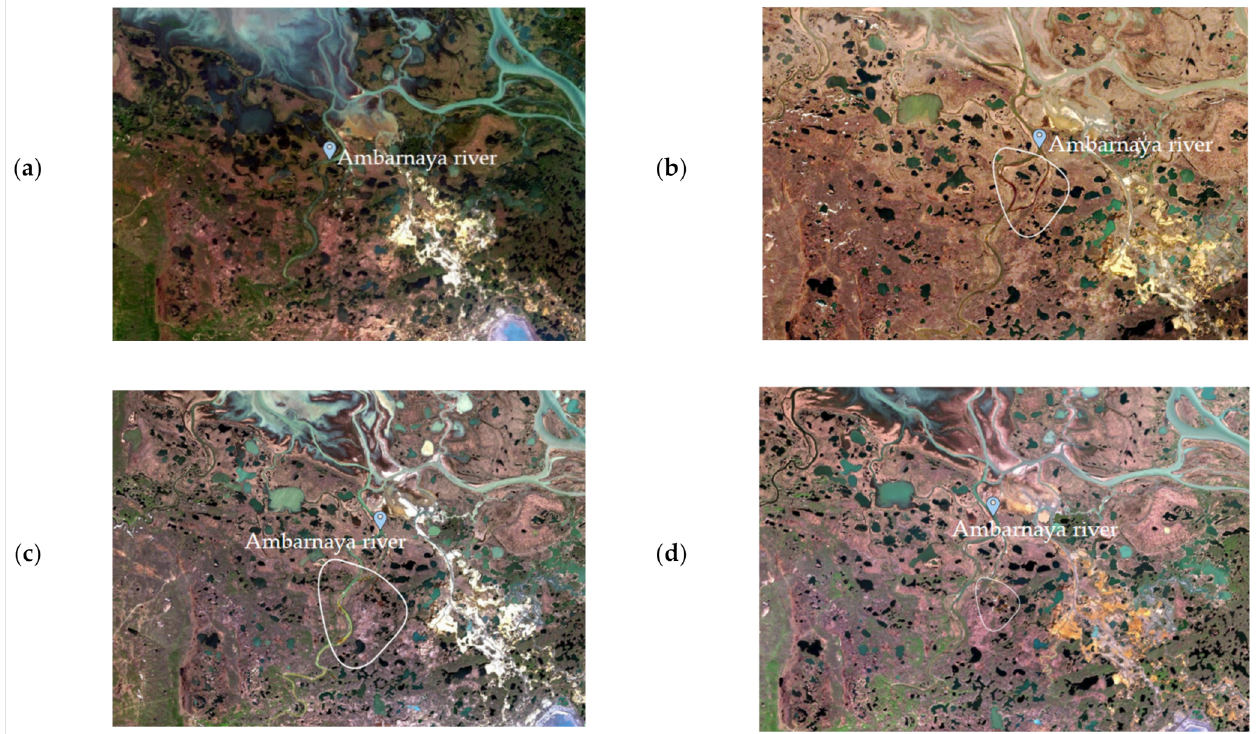
Figure 5. Visual Oil Spill Analysis ( a ) 10 May 2020, ( b ) 31 May 2020, ( c ) 8 June 2020, ( d ) 13 June